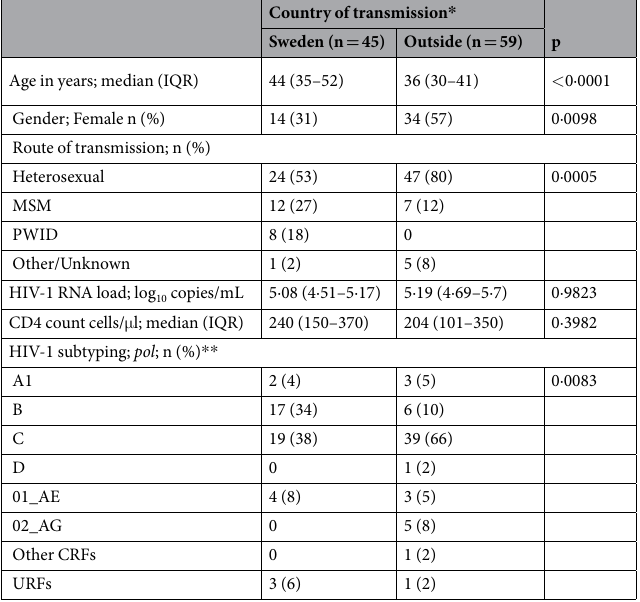
Table 1. Patient’s characteristics in whom near full-length HIV-1 genome sequencing was performed. MSM: men who have sex with men; PWID: people with intravenous drug use; CRFs: circulating recombinant forms; URFs: unique recombinant forms; * reported by the treating physician; ** based on the pol